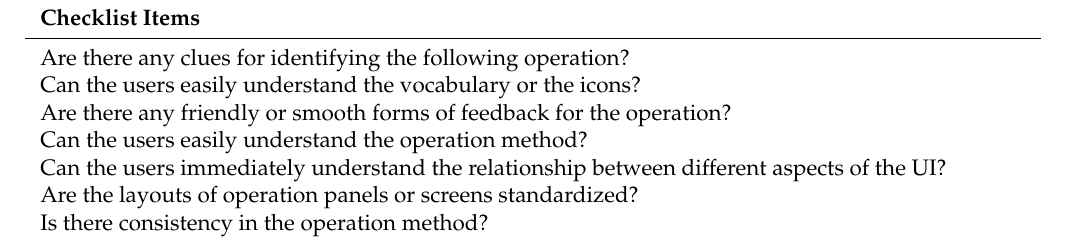
Table 3. Checklist items of pattern 1 (task-level).